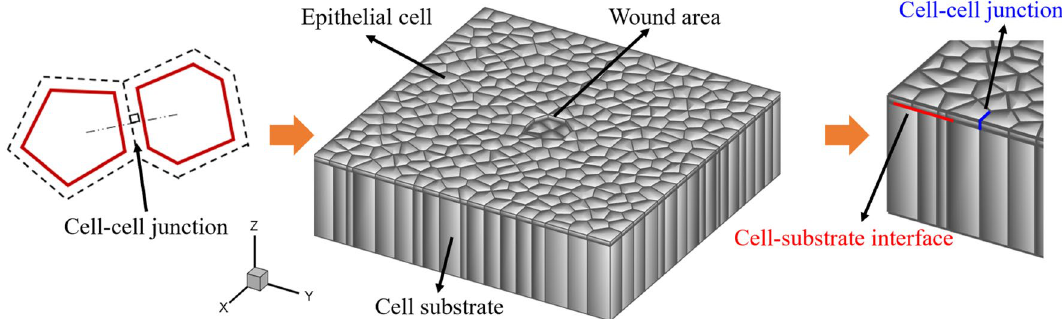
Figure 1. Process of generating the 3D geometry of epithelial monolayer sheet for the wound healing process. First, a 2D model of the epithelial monolayer sheet was generated via Voronoi tessellation. The wound was created by removing several cells in the middle of the sheet. The 2D model was then extruded to achieve the epithelium thickness. Eventually, an ECM substrate was built underneath the